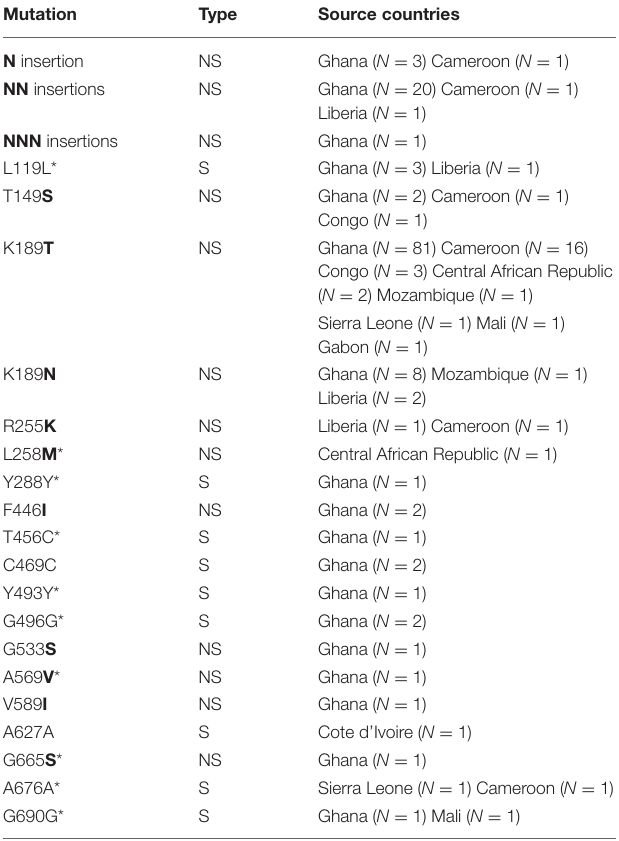
TABLE 2 | Pfkelch13 mutations from studied isolates. Mutation